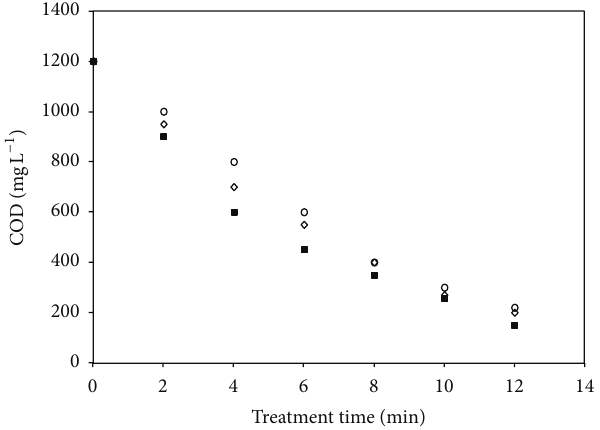
Figure 4: COD abatement as a function of treatment time when the coupled EC-ozonation process is used, and ( ◊ ) Fe, ( ◼ ) Cu, and (o) Al anode materials are employed. The initial pH was